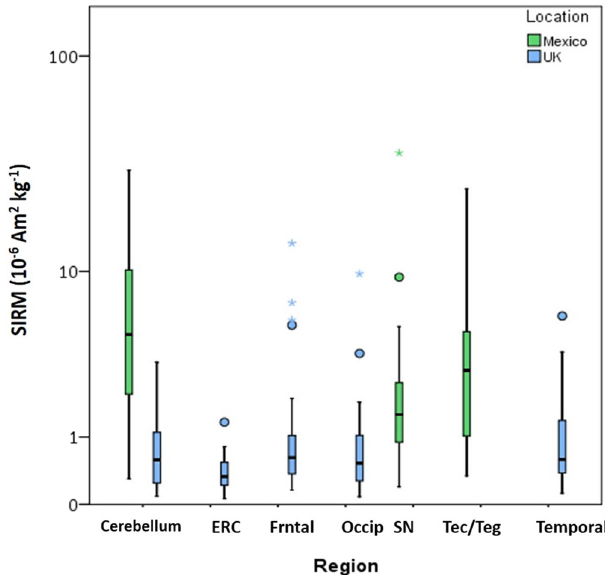
Figure 6. Box plot of mass-normalised SIRM values of human brain regions from Manchester, UK and Mexico City, Mexico. Box plots depict the mass-normalised (freeze-dried weights) saturation isothermal remanence magnetisations (SIRMs) of human brain tissue samples measured at 293 K from the cerebellum, entorhinal cortex (ERC), frontal lobe (Frntal), occipital lobe (Occip), and temporal lobe of cases from Manchester, UK, (blue) along with the cerebellum, substantia nigra (SN), and tectum/tegmentum (Tec/Teg) from Mexico City, Mexico (green) 31 . Outliers (open circle) are more than 1.5× the interquartile range, extremes (*) are more than 3× the interquartile